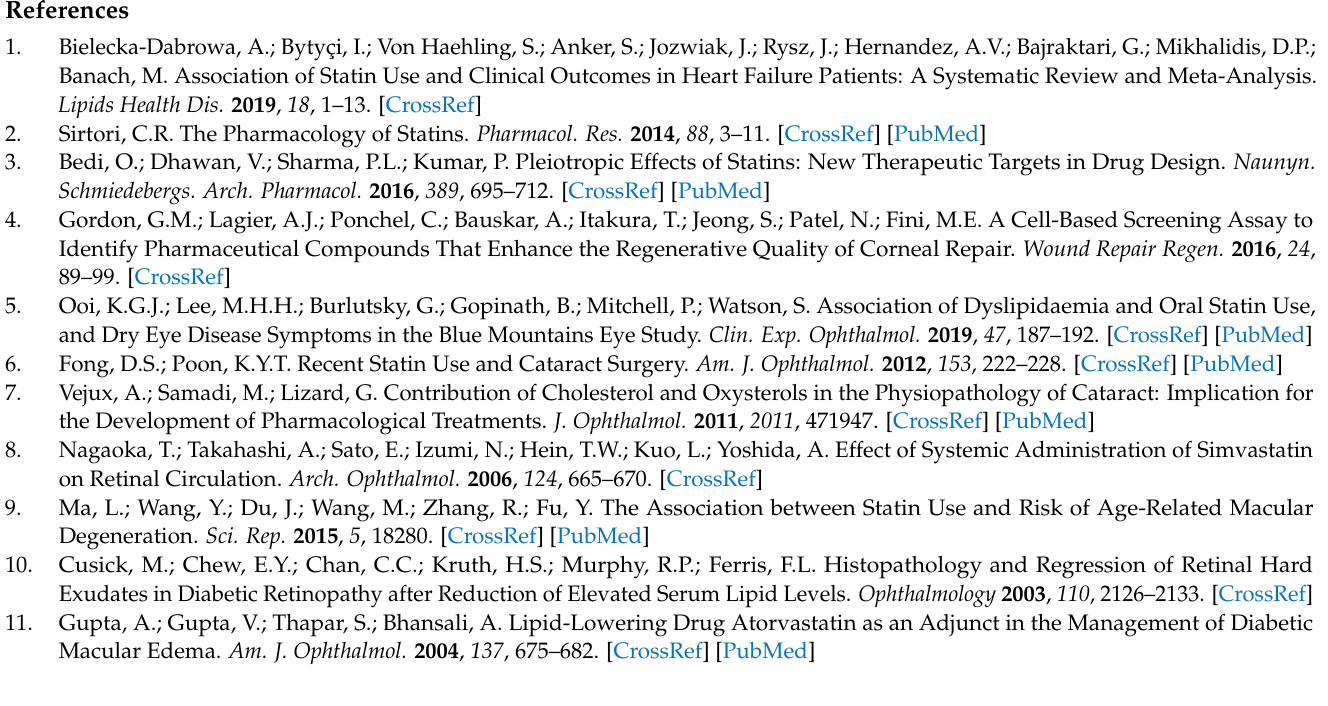
high hydrostatic pressure sterilization; Figure S6. HPLC chromatograms of the atorvastatin loading solution before and after sterilization processing applying steam heat and high hydrostatic pressure; Figure S7. Comparison of atorvastatin release profiles from hydrogels that had not been sterilized (WS) and hydrogels that had been sterilized by steam heat (SH) before loading; Figure S8. HPLC chromatogram of atorvastatin calcium solution (0.04 mg/mL in ethanol:water 20:80 v/v ) after 8 h of exposure to white